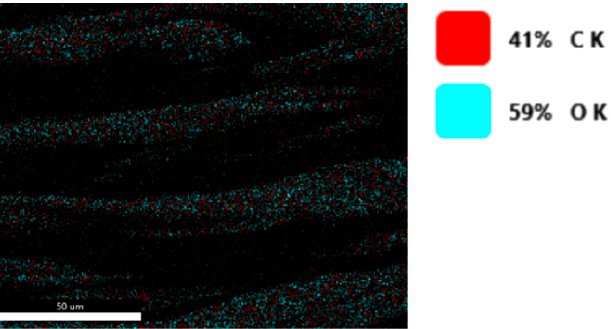
Figure 3. Smart elemental mapping overlay for sample 1 (fabric treated using a preliminary classical cleaning method, without conductive paste).